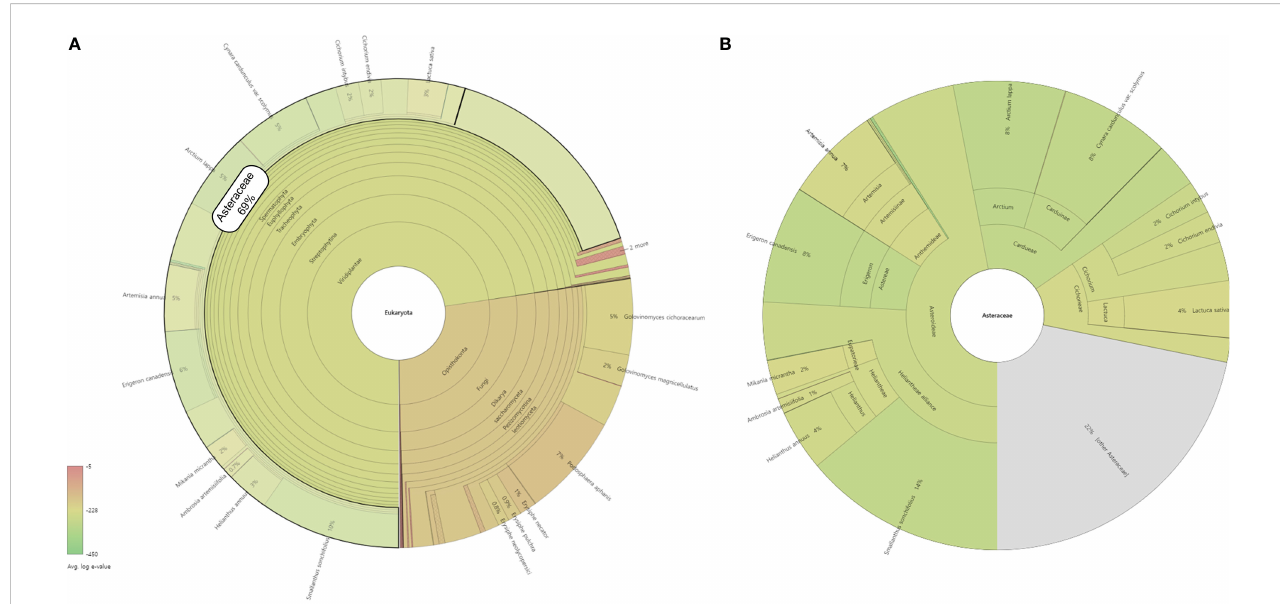
FIGURE 5 A taxonomic pro fi le of BLASTP results against the NCBI NR database with the highest taxon as (A) Eukaryota and (B) Asteracea. The circles from inside to outside represent different taxonomic rankings, while the area of the sector indicates the fraction of various OUT annotation fi